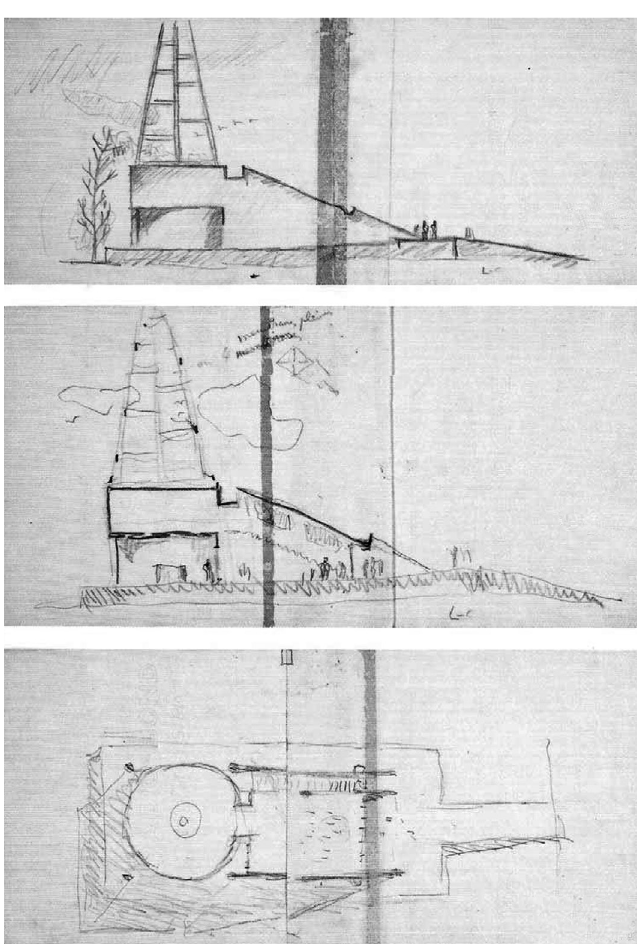
Fig. 1 Le Corbusier, Sketches for l’Èglise pour Bologne,